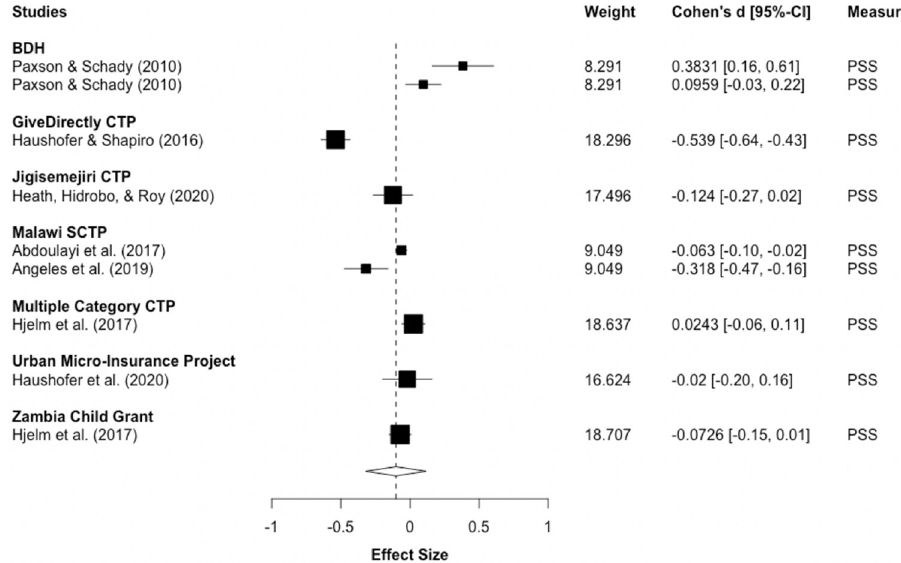
Fig 5. Stress post-intervention. Notes: RVE correlated effects model with small-sample corrections. Robust standard errors adjusted at program-level. Outcomes are coded so that negative Cohen’s d-values indicate improvements. Diamond and dashed line display overall estimate of d pooled = -0.102, width of diamond represents 95%-CI [-0.32, 0.12].